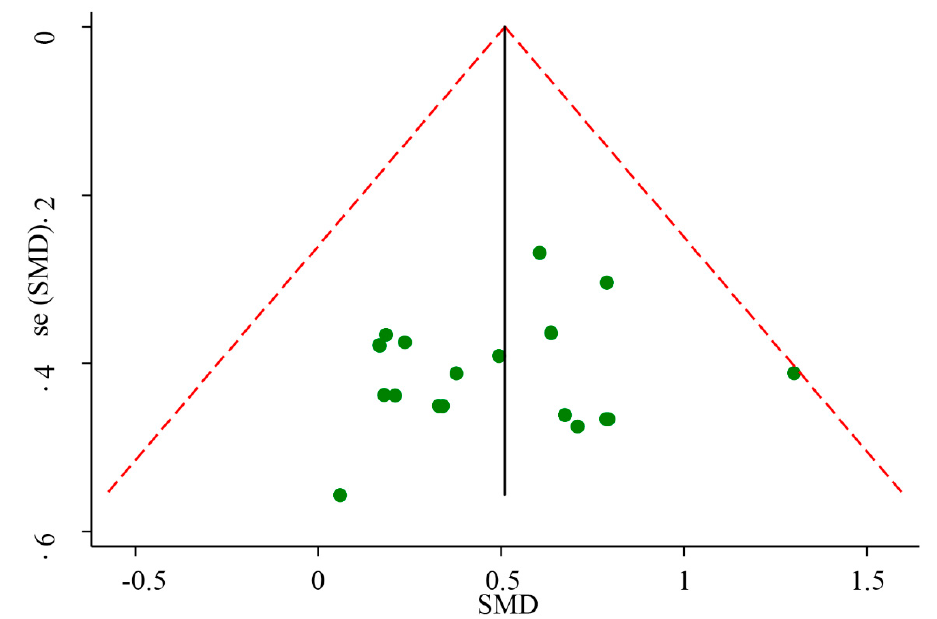
Figure 3. Funnel plot of standard difference in means versus standard error of 18 included studies.